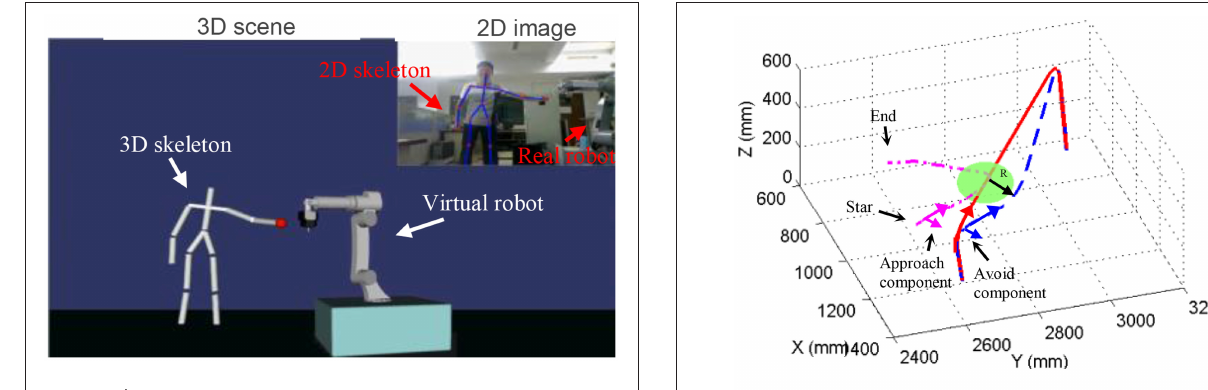
FIGURE 5 | Experimental scene (the person is Jetty and he consents for the Publication of the Manuscript).